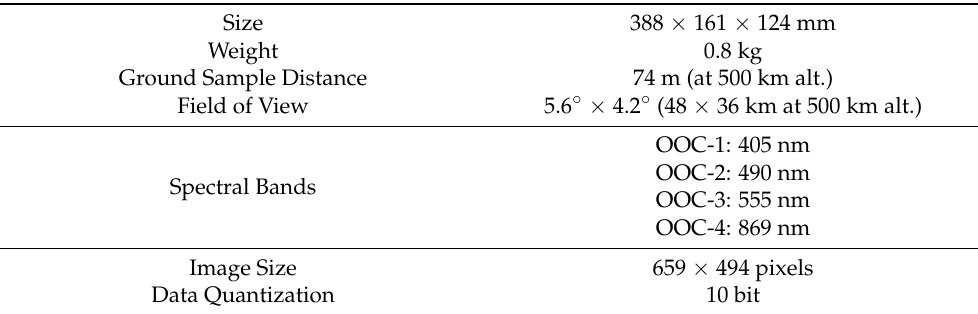
Table 1. Specifications of the OOC.